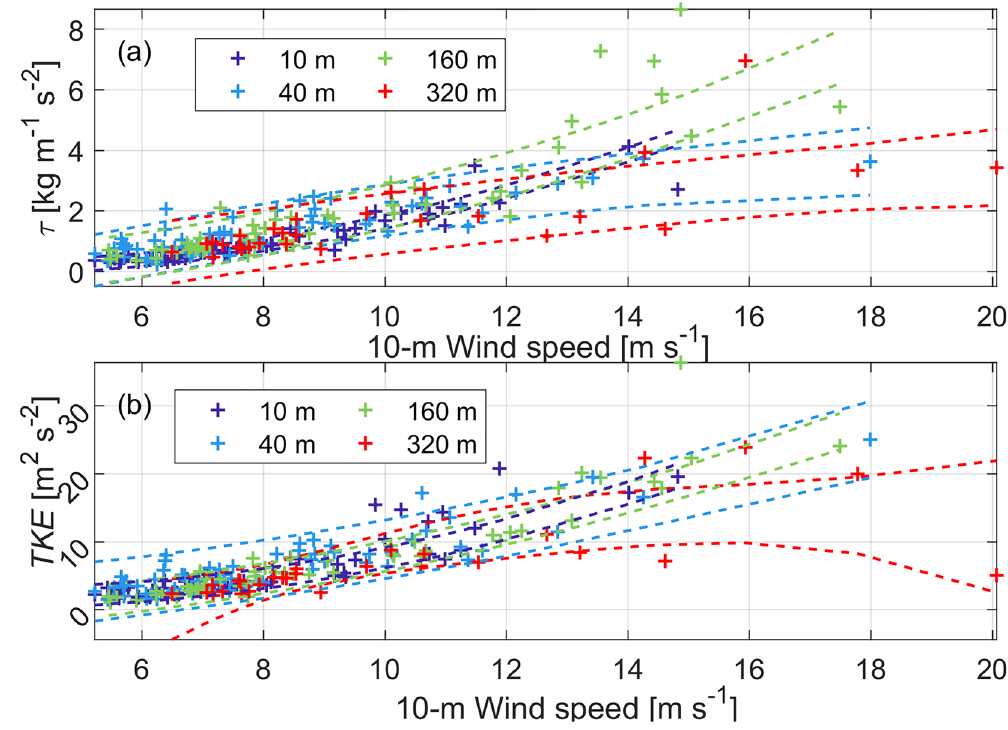
Figure 7. Plots of ( a ) momentum flux (τ) and ( b ) turbulent kinetic energy ( TKE = ( u ′ 2 + v ′ 2 + w ′ 2 )/ 2 ) as a function of the 10-m wind speed at four levels, 10, 40, 160 and 320 m. The 4 couples of dashed lines in same color as the + in ( a ) and ( b ) denote the corresponding 95% confidence intervals. Panels ( a ) and ( b ) share the same